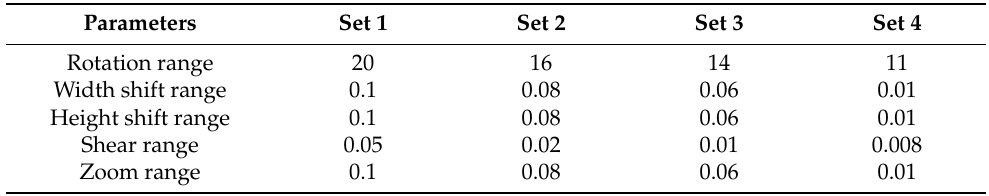
were tested (Table A2). Excessive data augmentation reduces the accuracy, while sets with little augmentation increase overfitting. Thus, set 3 was deemed the best option to address the problem of overfitting. Table A2. Sets tested for data augmentation. In all the tests, the horizontal flip and fill mode = the “nearest” was used. Model L7 in Table A1 was used for these